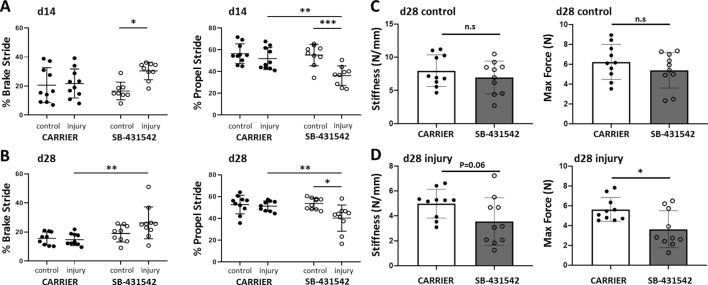
TGFβ signaling is required for functional recovery.Gait analysis at (A) d14 and (B) d28 showed impaired % brake stride and % propel stride after injury with SB-431542 treatment. (C, D) Tensile testing at d28 revealed reduced stiffness and max force with SB-431542 treatment. *p<0.05, **p<0.01, ***p<0.001 (n = 8–10 mice).